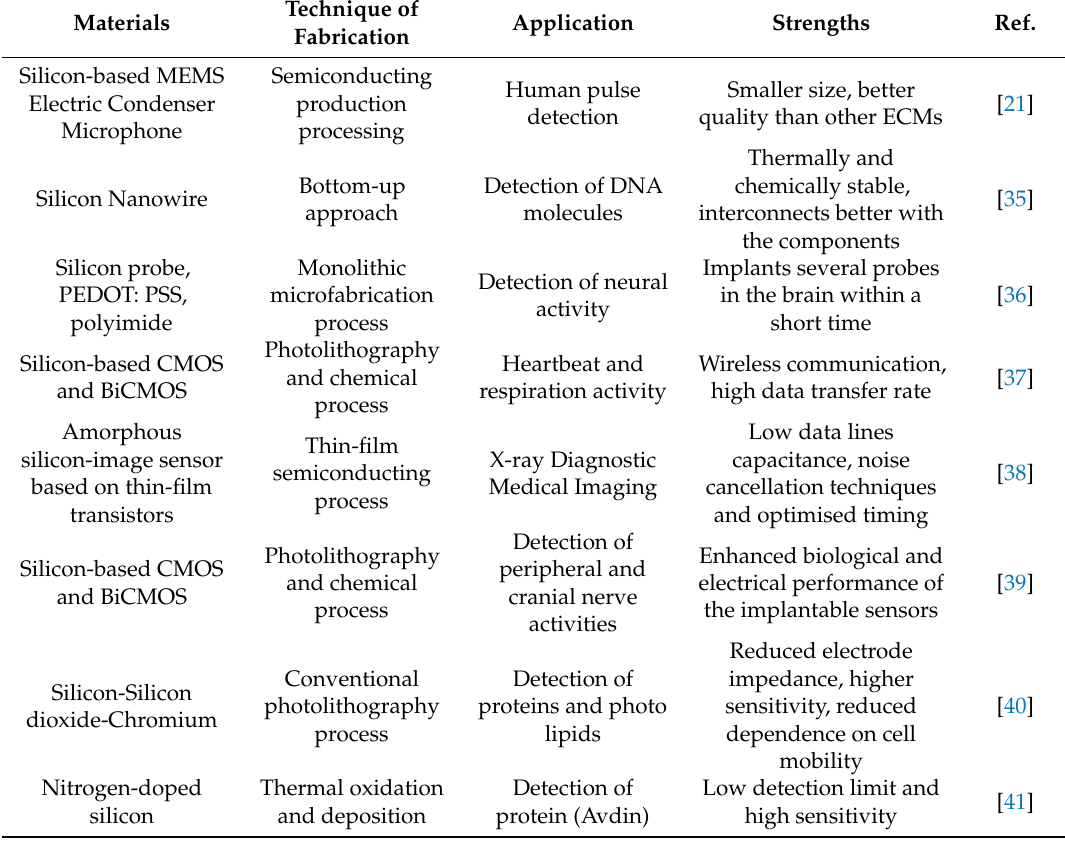
Table 1. A comparative study of the di ff erent silicon-based sensors used for biomedical